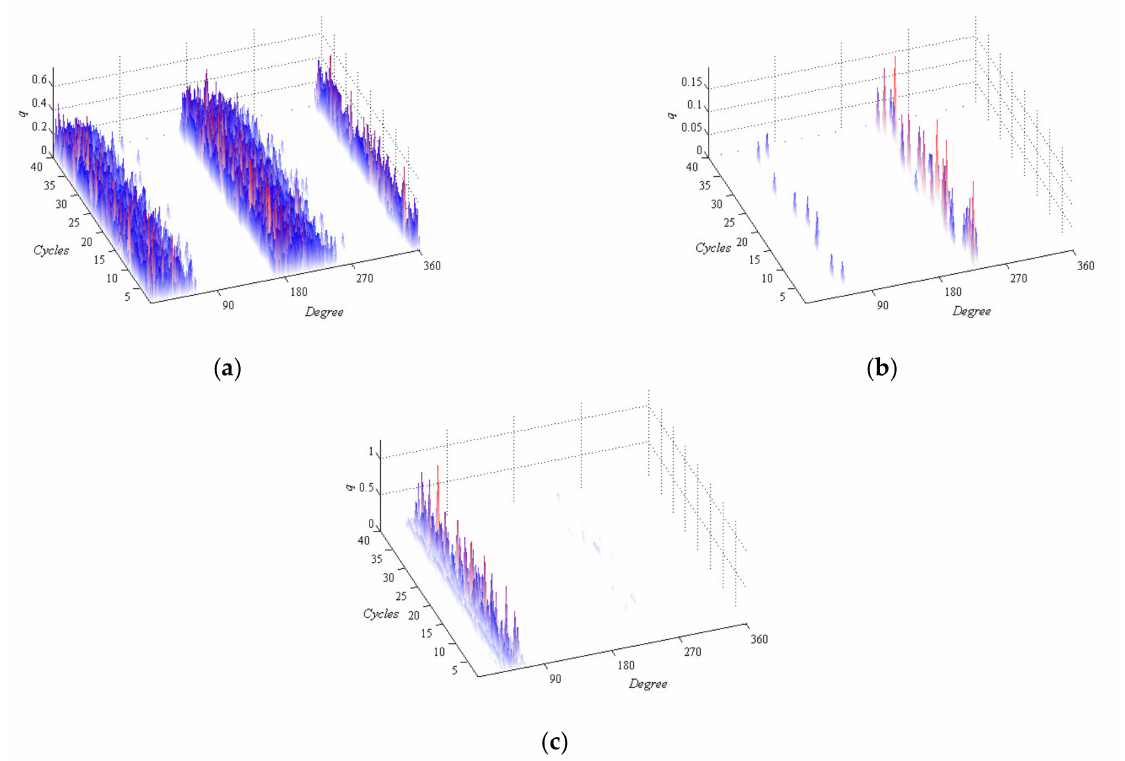
Figure 7. 26 kV q − t − ϕ patterns: ( a ) GIS-1; ( b ) GIS-2; ( c )